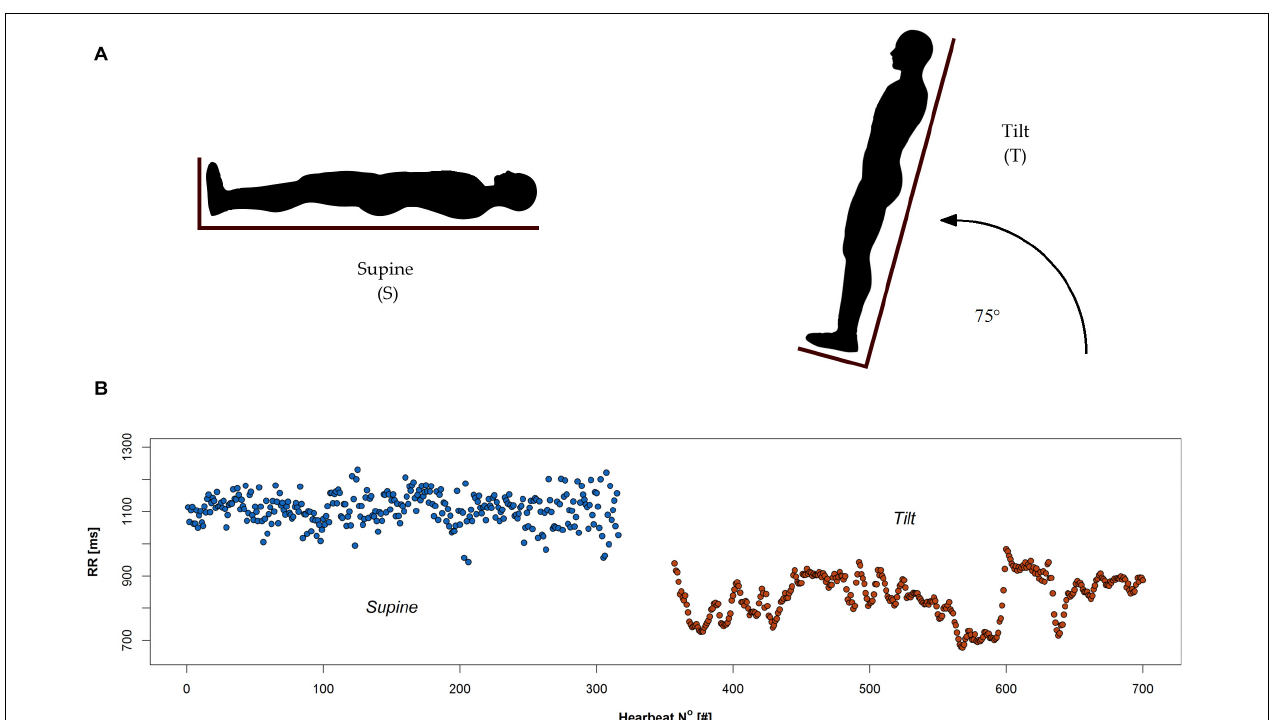
FIGURE 1 | Head up tilt test: (A) schematic illustration of supine (S) and tilt (T) phases, and (B) an example of RR series recorded during the test.